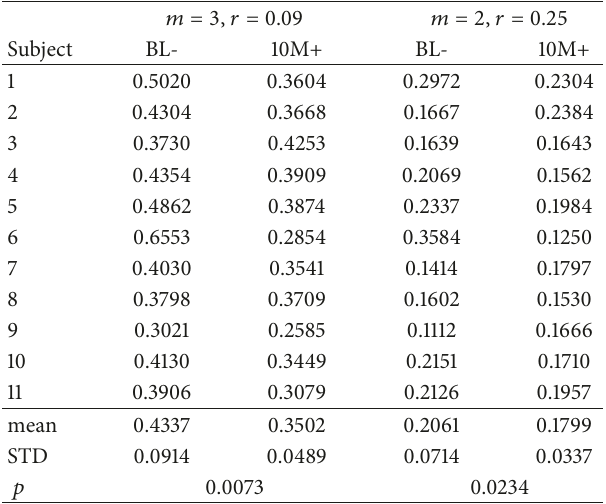
Table 8: SampEn individual, mean, and standard deviation (STD) values of the two classes studied, BL- and